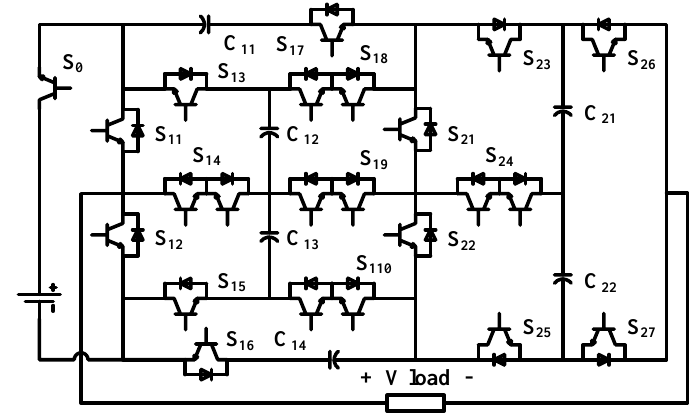
Figure 2. A 25-level prototype based on the proposed SCMLI structure.